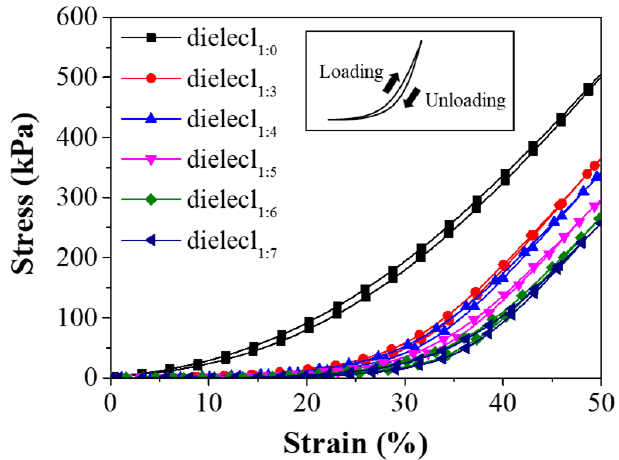
Figure 5. Mechanical properties of the dielectric layer samples.